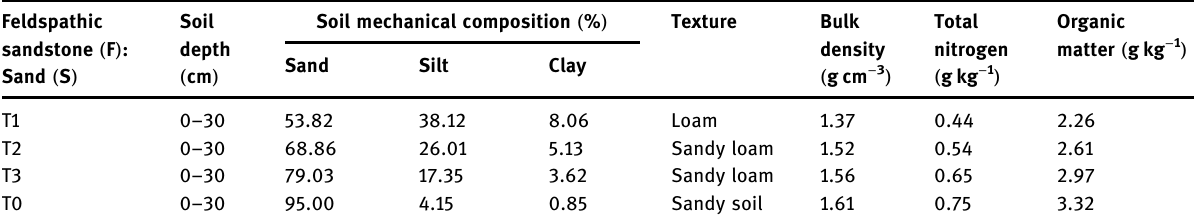
Table 1: Main physical and chemical properties of soils reconstructed by feldspathic sandstone and sand Feldspathic